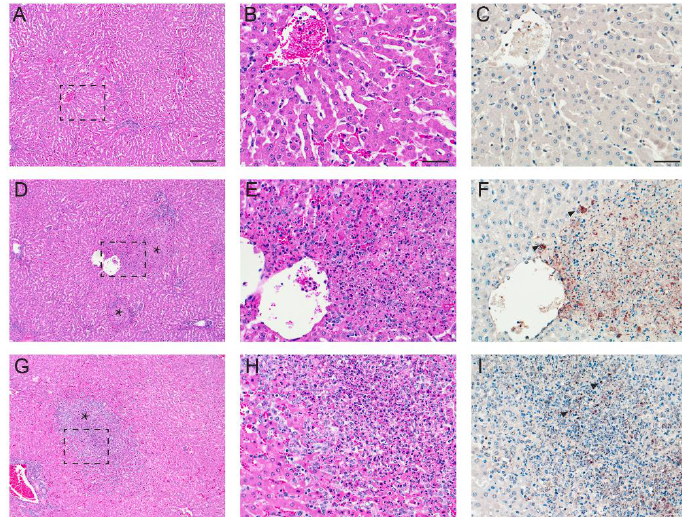
Figure 5. Acute time-point liver histopathology and viral antigen immunohistochemistry. ( A ) Shown is a low magnification hematoxylin and eosin (H&E) stain of the normal liver histology seen in mock-inoculated Animal #42; the black broken line box outlines the area magnified in ( B ); ( C ) viral antigen immunohistochemistry is negative for RVFV antigen; ( D ) the depicted Ken06, 3 dpi, Animal #41 liver H&E is representative of the acute time-point histopathology seen in animals inoculated by this virus; the black stars mark necrotic foci; a portion of one focus is magnified in (E) ; (F ) shown is the same necrotic focus, which is strongly positive for RVFV antigen in hepatocytes, macrophages and cellular debris; black arrowheads indicate cytoplasmic positive labeling; ( G ) the depicted SA01, 3 dpi, Animal #43 liver H&E is typical of acute time-point liver histopathology for this virus strain; the black star denotes a single large necrotic focus further magnified in ( H ); acute time-point SA01 liver foci labeled sporadically and less strongly for RVFV antigen when compared to Ken06 foci; ( I ) a stronger than average viral antigen labeling for this larger than average necrotic focus in Animal #43; black arrowheads denote RVFV antigen labeling. Column 1 images are 100 ˆ magnification. The bar is 20 µ m. Columns 2 and 3 images are 400 ˆ magnification. Bars are 50 µ